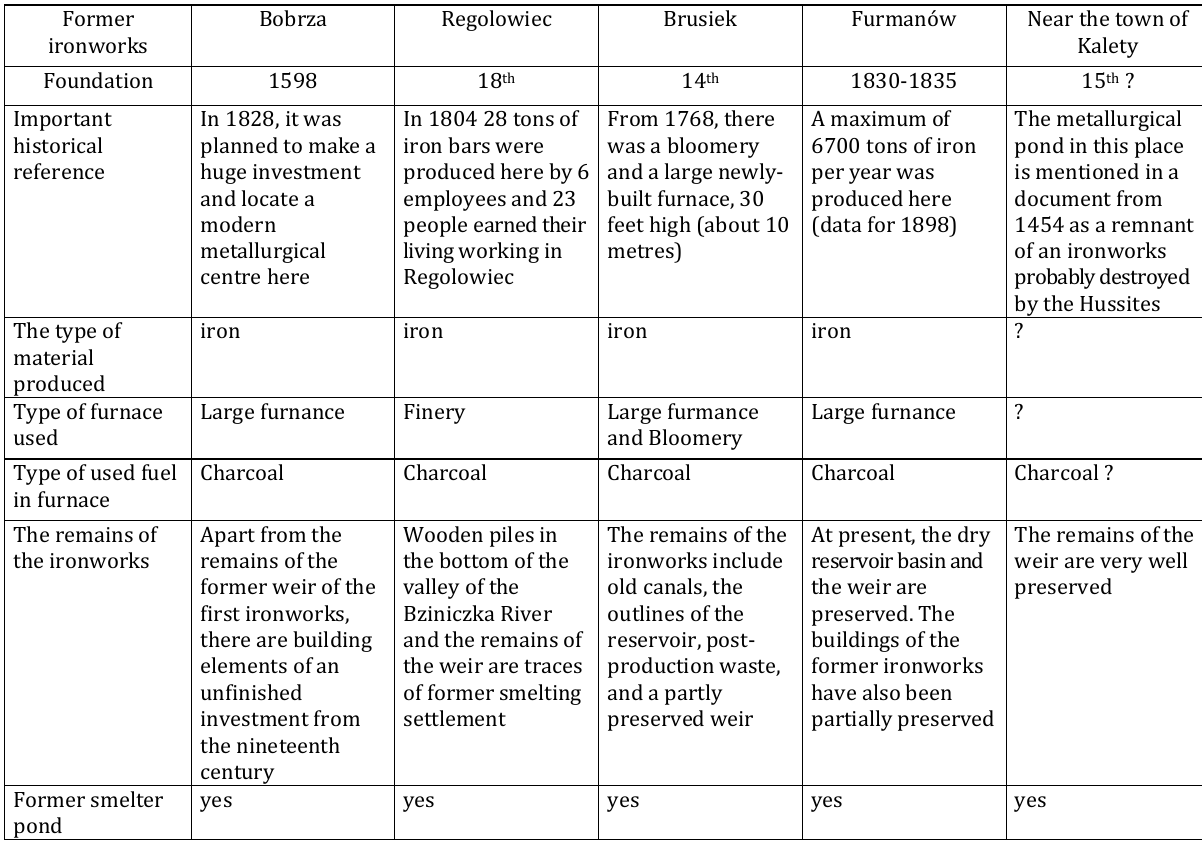
Table 1. The main characteristics of each river ironworks based on: Król et al., 2009; Globisch, 2004; Malik et al.,